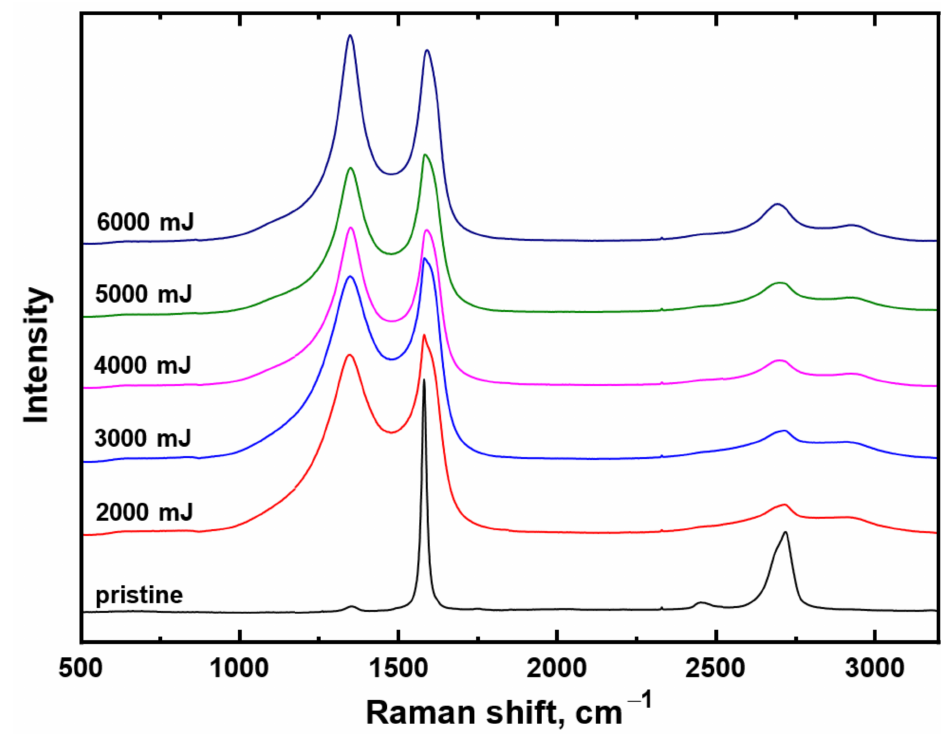
Figure 6. Average Raman spectra for each characterized sample—pristine carbon sheet and the substrate exposed with single-shot excimer with laser fluence ranging from 2000 mJ · cm − 2 to 6000 mJ · cm − 2